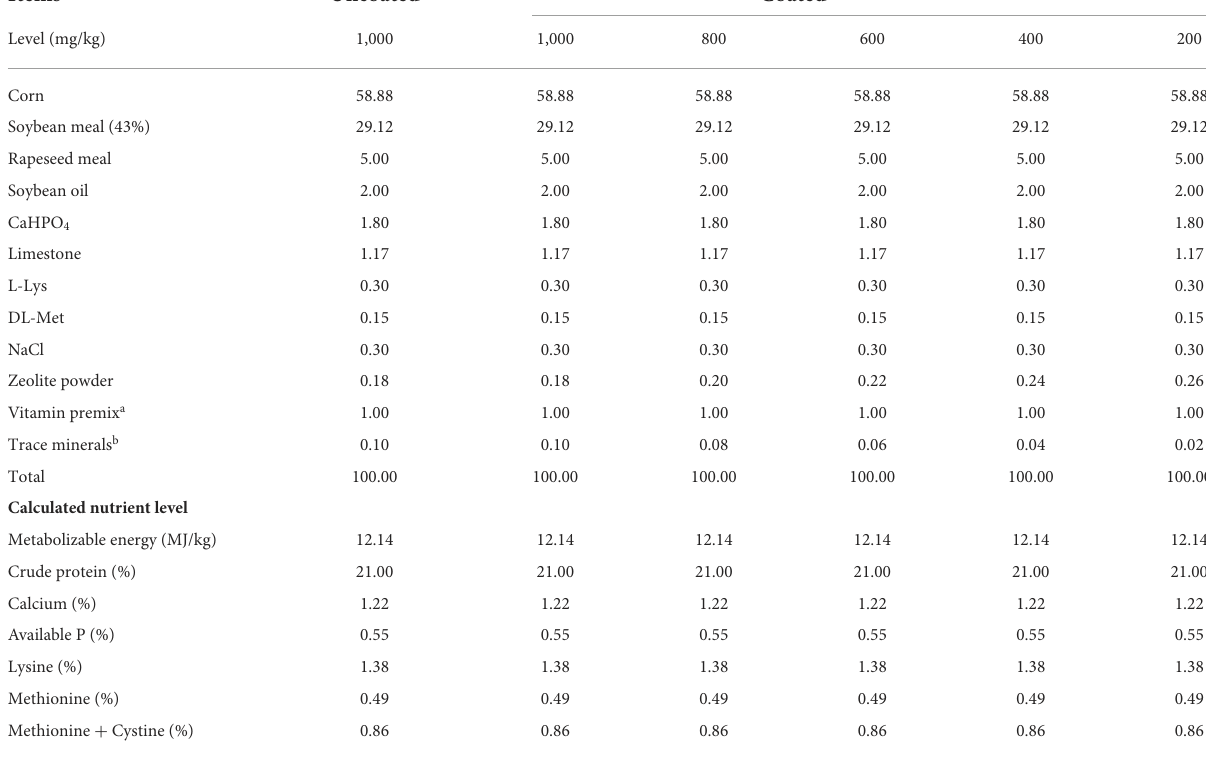
TABLE 2 Composition and nutrient levels of the diets for the starter period (1–28